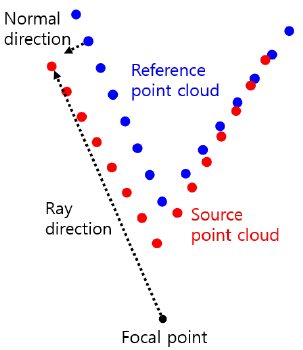
Figure 1. An unstable case in which the point-to-plane distance is hard to minimize by moving the source point in the ray direction. The red and the blue points represent a source and a reference point cloud, respectively. The ray direction is nearly orthogonal to the surface-normal